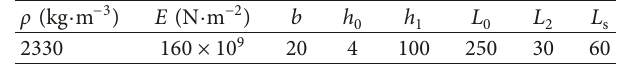
Table 2: Material properties and dimensions (unit of length: μ m). ρ (kg · m − 3